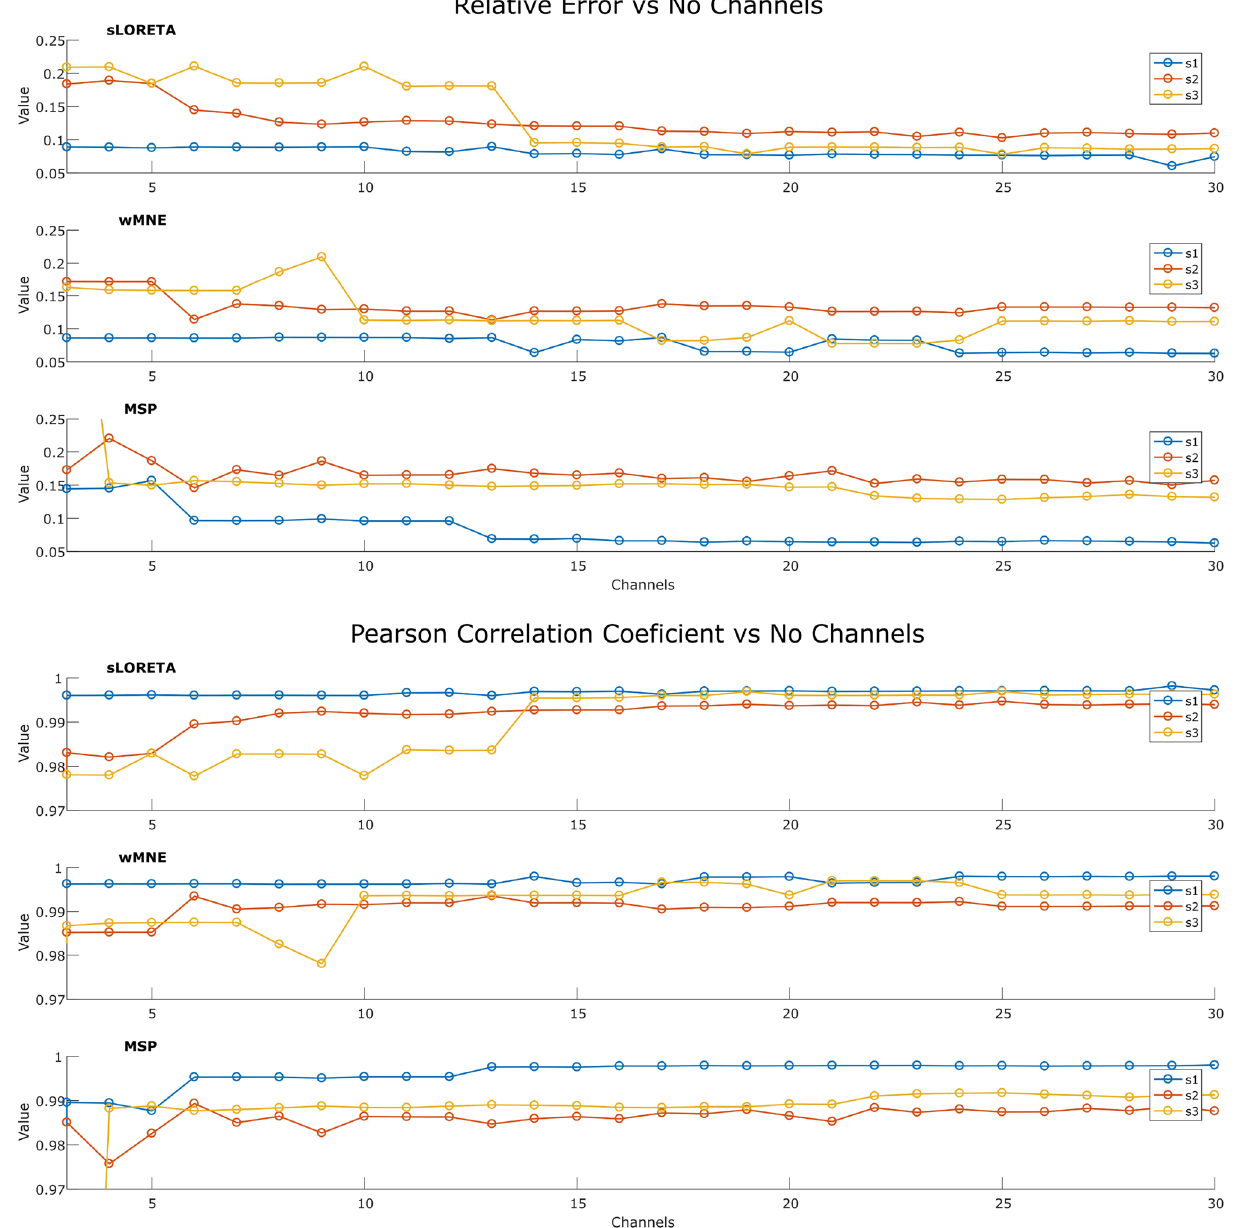
Figure 10. Relative error and Pearson correlation coefficient for each source, comparing the pseudo-Pareto combinations with the full set of 231